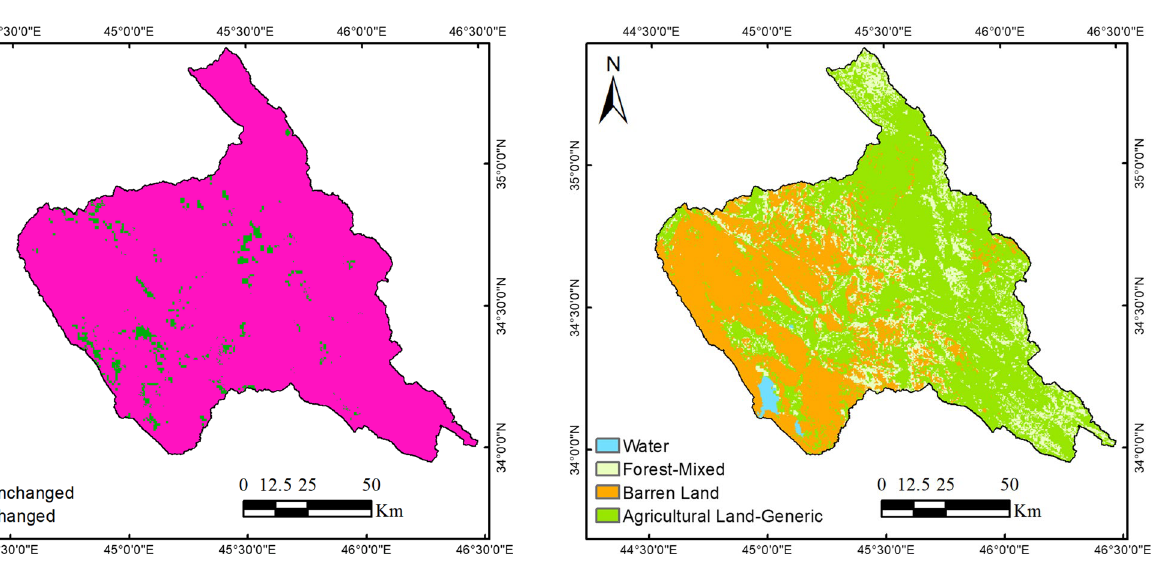
Fig. 7 Land cover/use of Hemren dam reservoir catchment